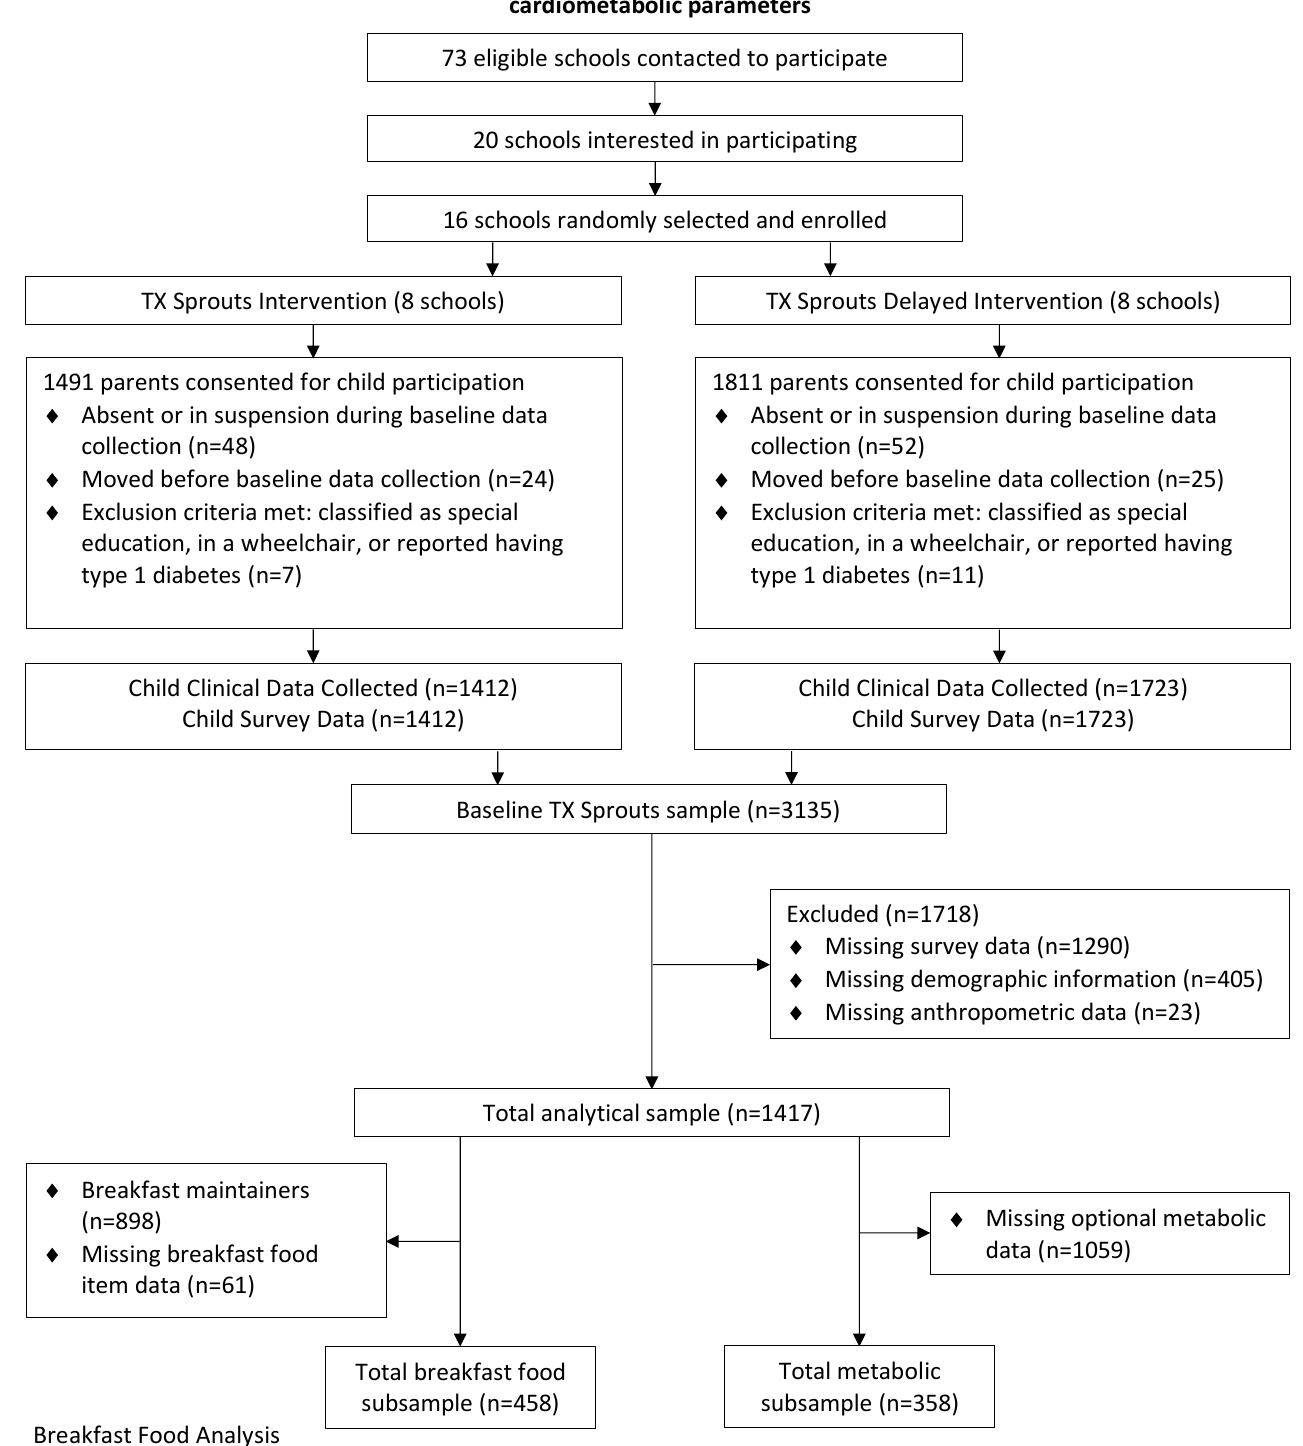
Figure 1. Consort diagram of TX Sprouts sample for examining breakfast consumption patterns with cardiometabolic parameters.